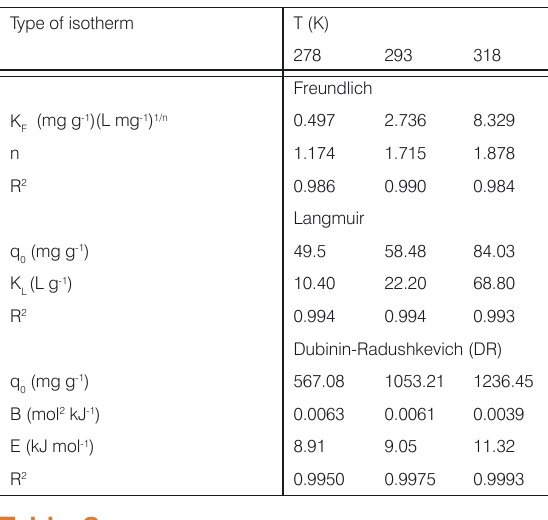
Table 2. Isotherm parameters for the sorption of reactive dye Bril- liant-Red HE-3B on HPAN fibres. Type of